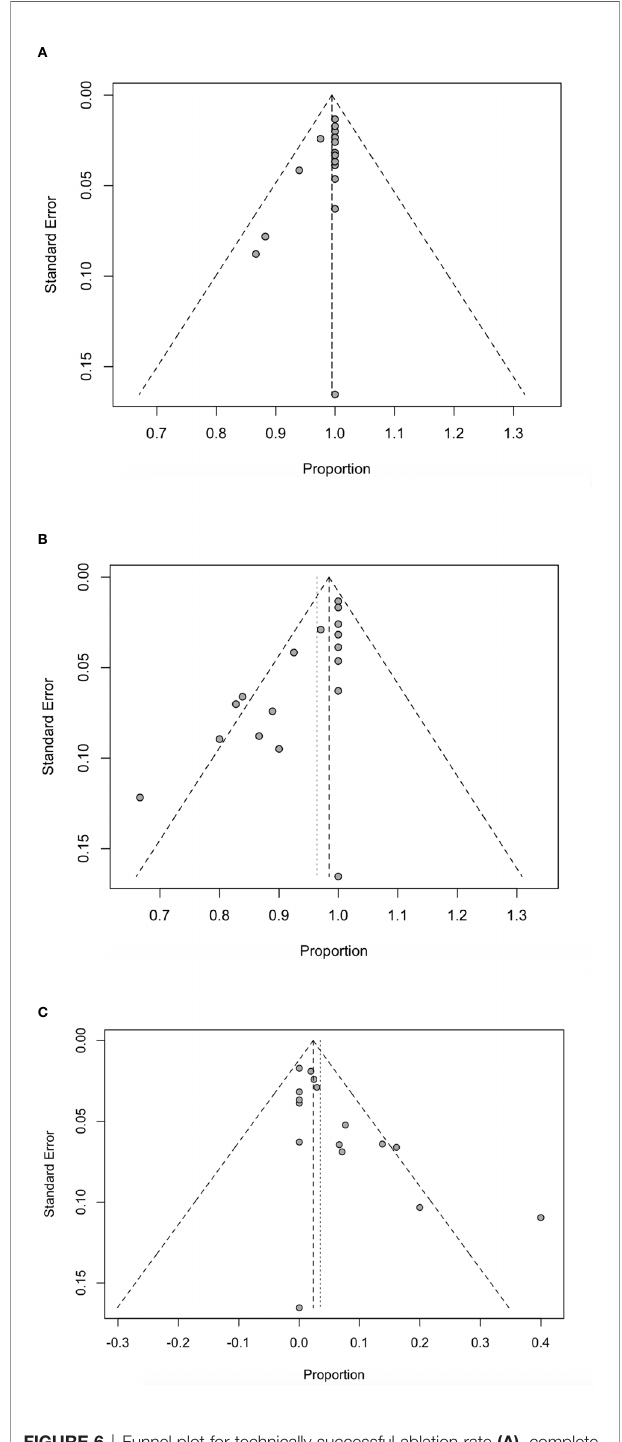
FIGURE 6 | Funnel plot for technically successful ablation rate (A) , complete ablation rate (B) and complications rate (C) in patients receiving